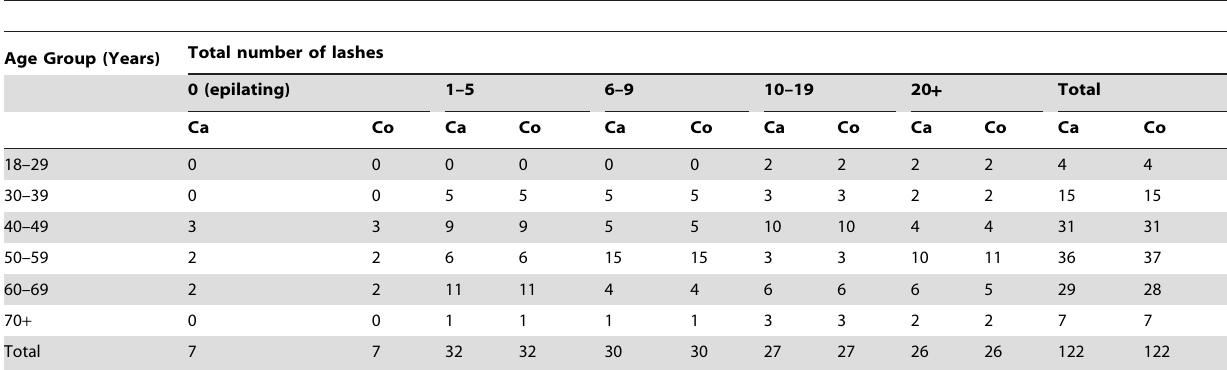
Table 1. Baseline distribution of age groups and trichiasis severity groups for both cases (Ca) and controls (Co).